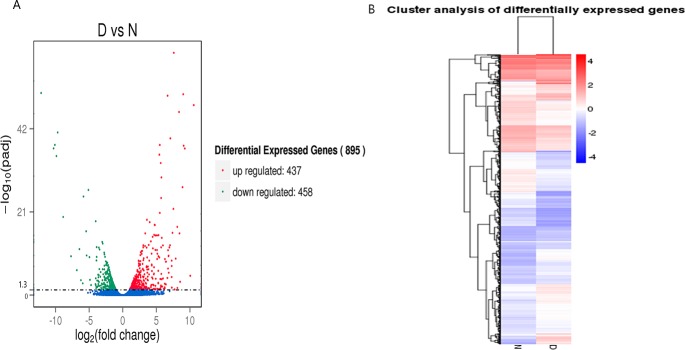
Differential expressed genes filtering.(A) In the volcano diagram, the significantly up-regulated genes are in red and the down-regulated genes are in green, while no difference is indicated in blue by the standard of p-adjusted< 0.05. (B) A heat map of N and D sample gene expression clustering, with high levels of expression shown in red and low levels shown in blue.